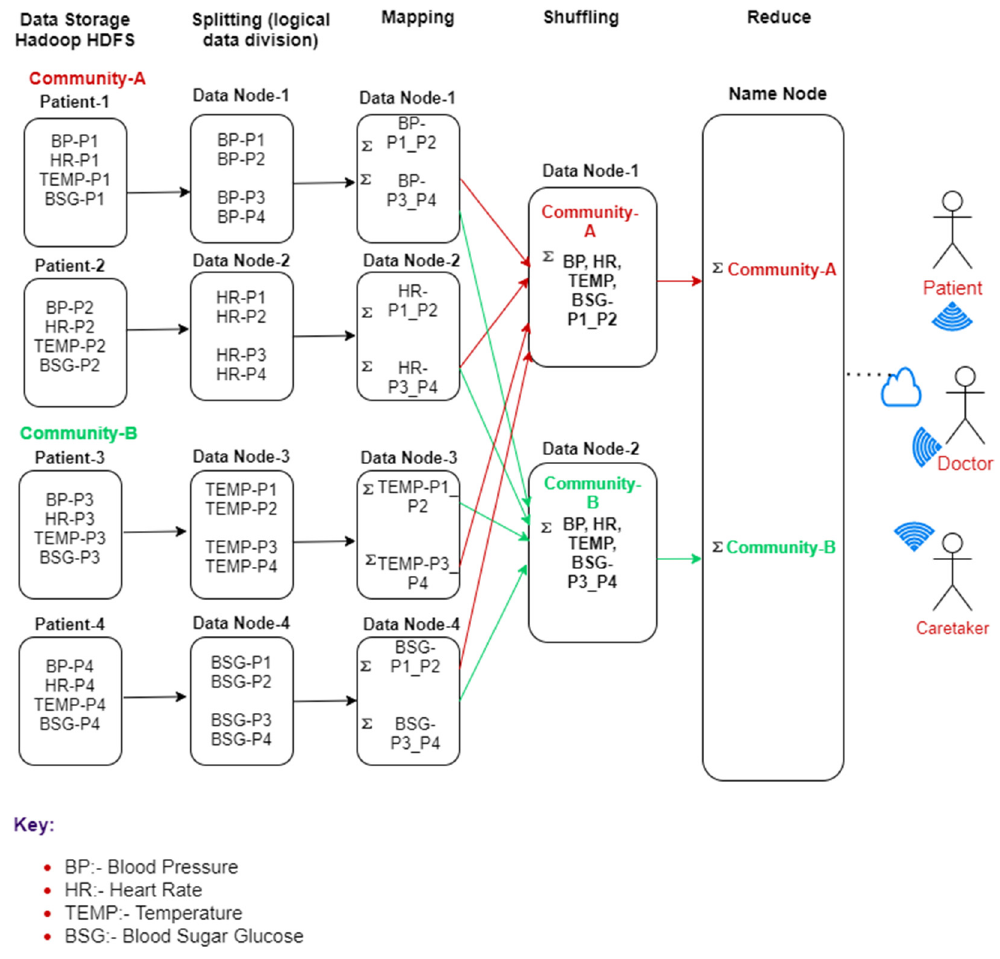
Figure 6. Use-case analytics’ paradigm for a smart healthcare patient monitoring digital twin in DAVL using Mapp-Reduce modeling presentation.